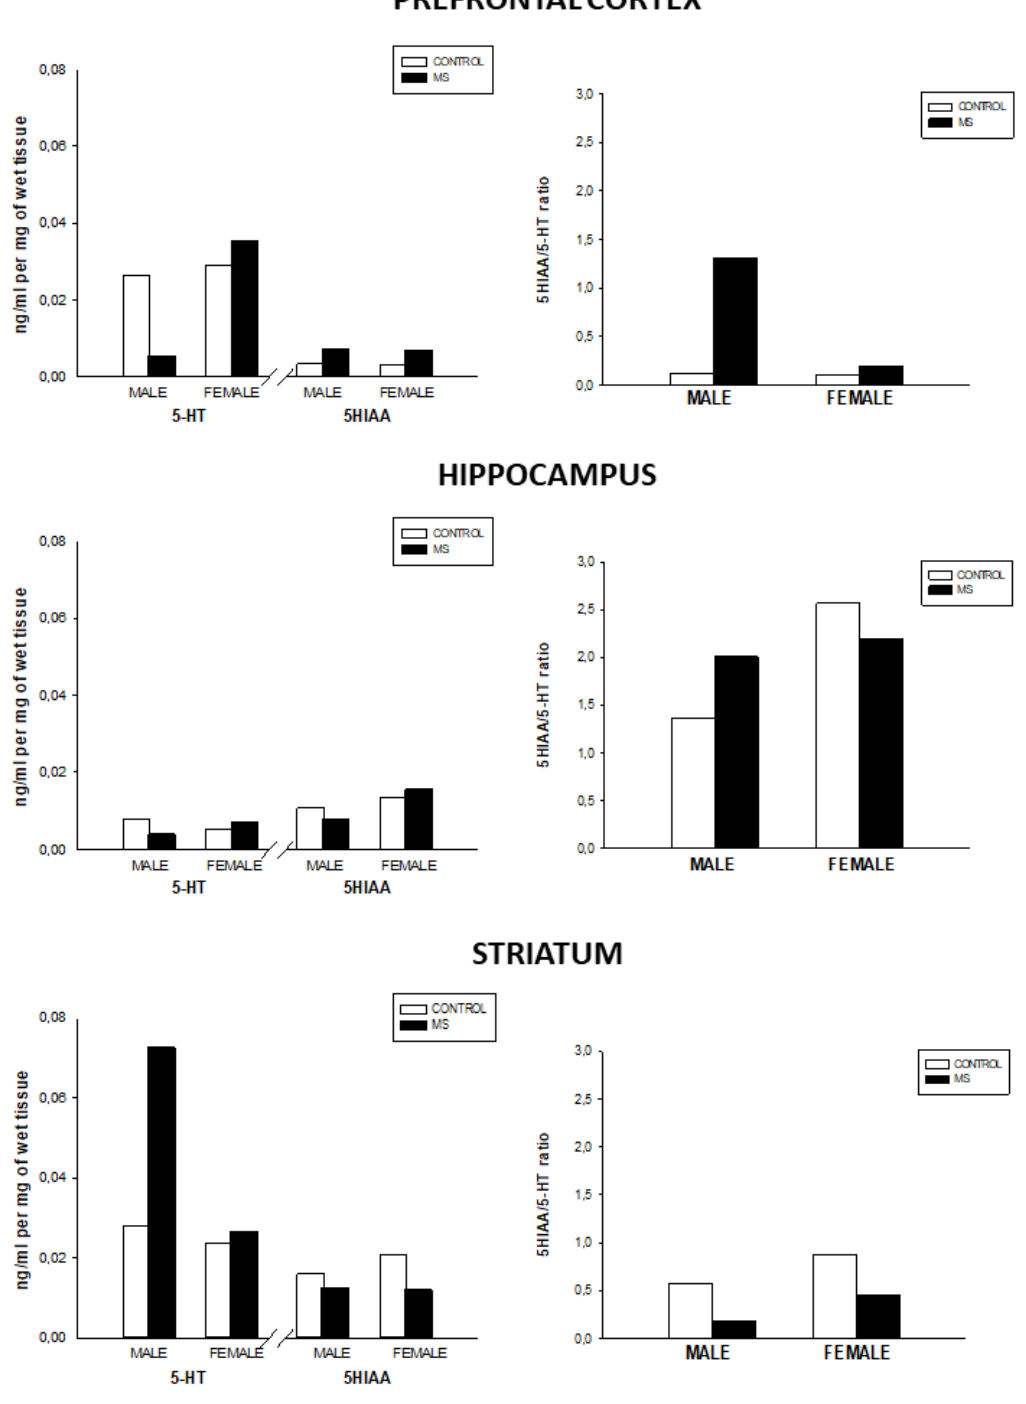
Figure 3. 5-HT, 5-HIAA levels (ng/mL per mg of wet tissue), and 5-HT turnover (5-HIAA/5-HT ratio) in the prefrontal cortex, hippocampus, and striatum for the control and MS groups.